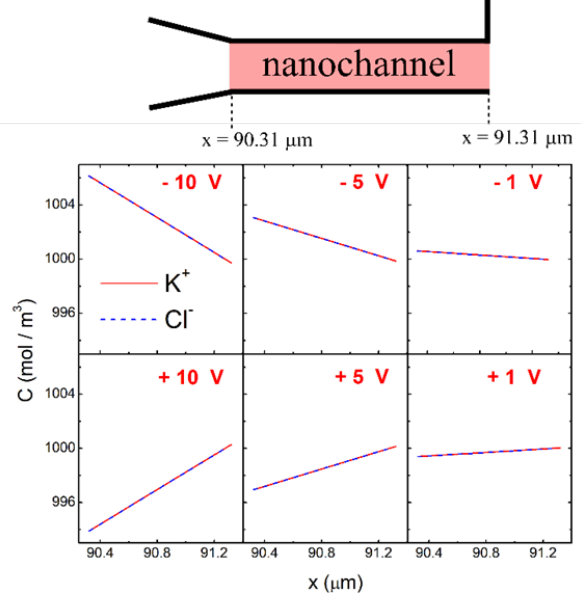
Figure 4. K + (red line) and Cl − (dashed blue line) ion concentration along the longitudinal section of the nanochannel as a function of the applied voltage between the reservoirs (C Bulk = 1 M = 10 3 mol / m 3 ).